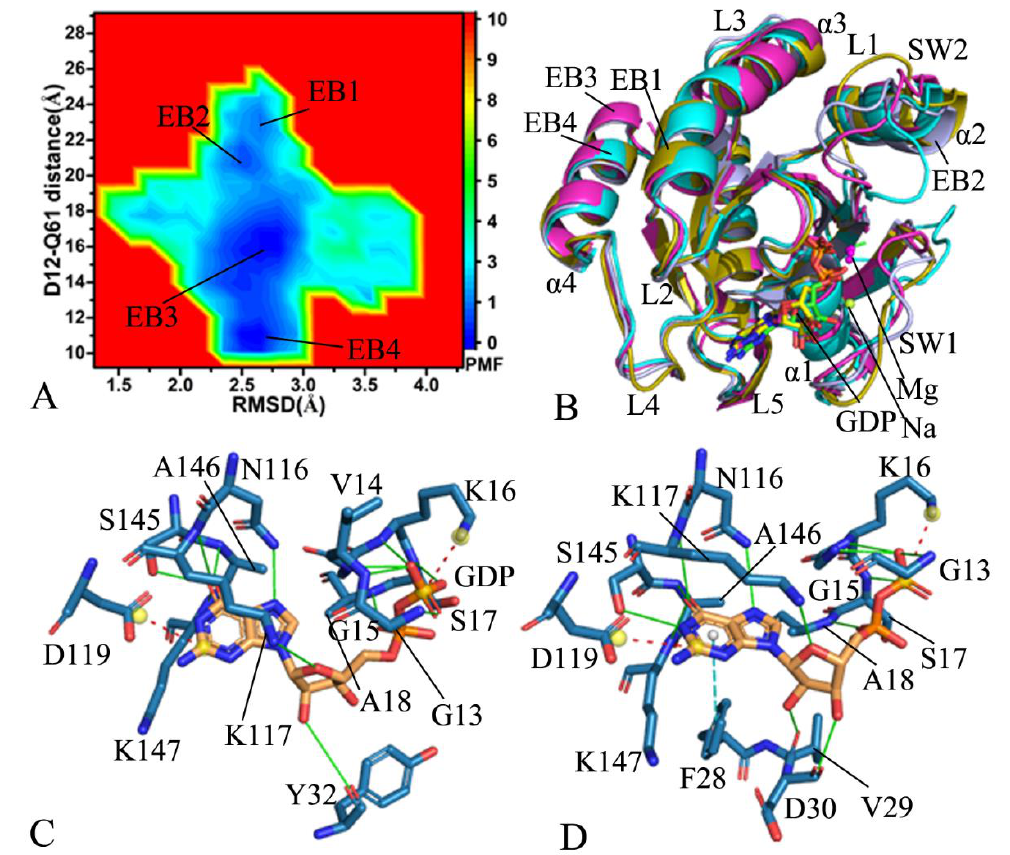
Figure 5. Free energy profile of structural information of the GDP-bound G12D KRAS: ( A ) the FEL built by using the RMSD and the distance of Y32 away from Q61, ( B ) superimposition of structures for KRAS in the EB1-EB4, ( C ) the GDP-residue interaction in the most incompact state of the switch domains, and ( D ) the GDP–residue interaction in the tightest state of the switch domains. The PMF is scaled in kcal/mol.